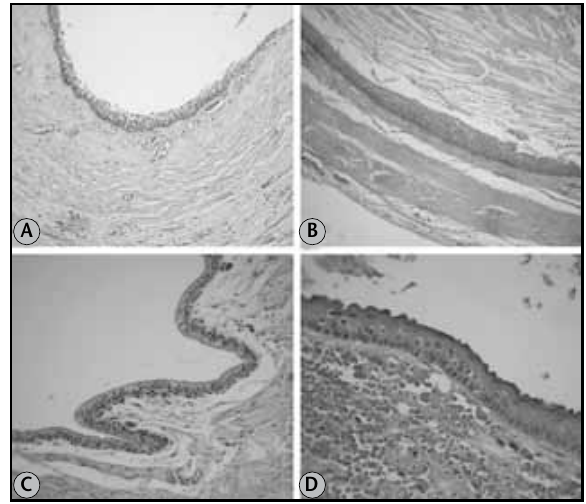
Figura 4 – Análise histopatológica (HE,